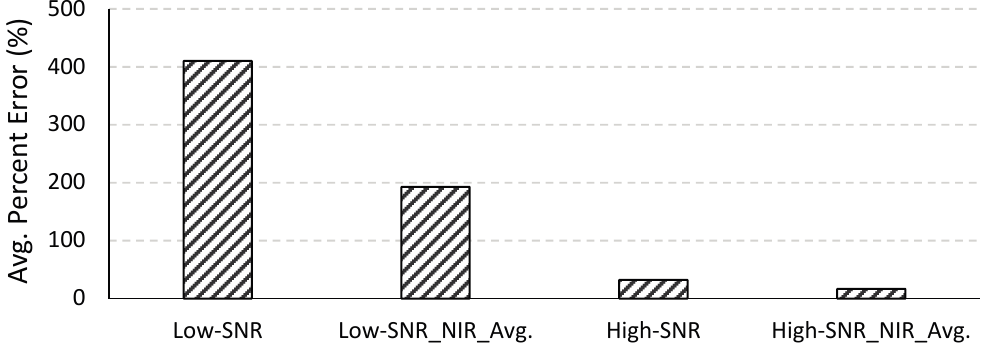
Figure 10. Average percent errors in the chl- a concentrations retrieved using the two-band NIR-red algorithm for the low- and high-SNR systems with and without spatial averaging in the NIR spectral